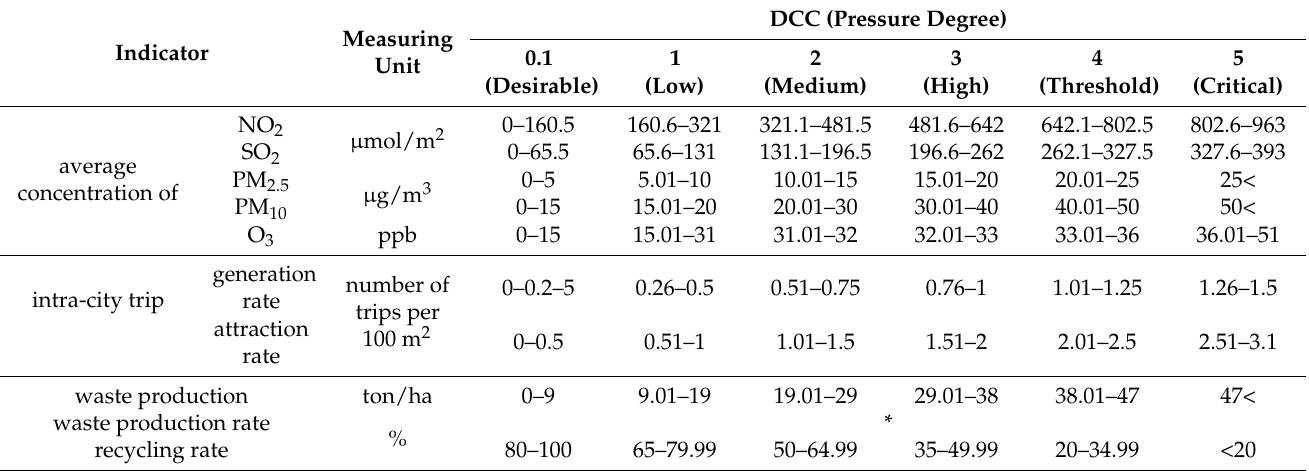
Table 3. DCC classes of